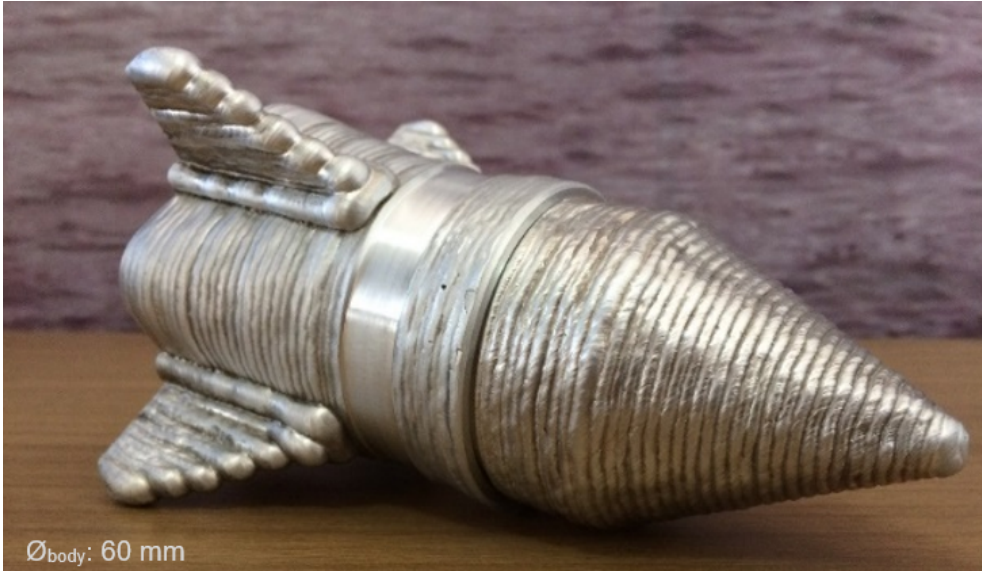
Figure 1. Thin-walled part of ER-5356 continuously deposited by WAAM with proper thermal management (Near-immersion Active Cooling technique as developed by da Silva et al. [6]) during preliminary tests (the continuous deposition, especially of the nose cone, would not be possible without proper thermal management due to the intense deposition concentration and consequent heat